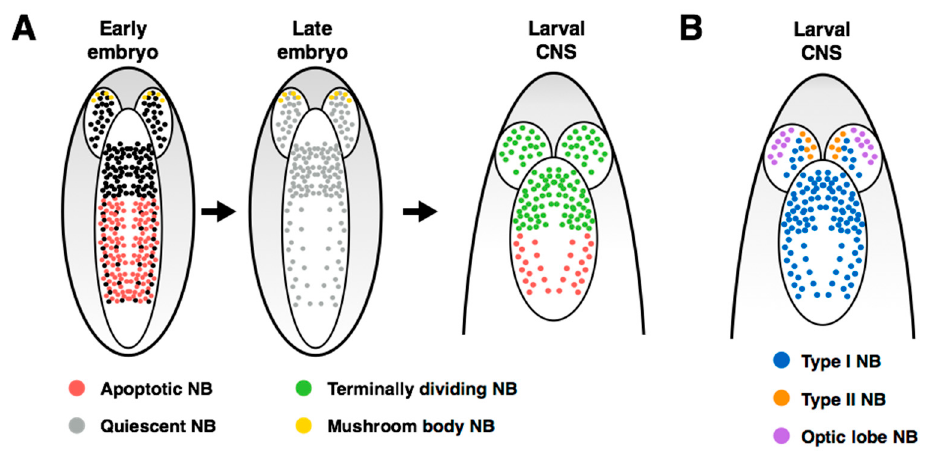
Figure 2. Neuroblast populations within the Drosophila central nervous system. ( A ) Cell-fate decisions are mapped onto anatomical populations of neuroblasts during embryonic and larval development. The majority of abdominal neuroblasts undergo apoptosis during embryogenesis, leaving 3 neuroblasts per hemisegment in the larval CNS. Neuroblasts stop proliferating between embryonic and larval development, except for 4 mushroom body neuroblasts. Following reactivation, neuroblasts in the thorax and brain undergo terminal division, while the remaining abdominal neuroblasts die through apoptosis. ( B ) Proliferation patterns of neuroblasts throughout the larval CNS. Most neuroblasts use the Type I division pattern, except a small population of Type II neuroblasts in the brain. The neuroblasts in the inner proliferating center of the optic lobe have been observed to divide symmetrically.